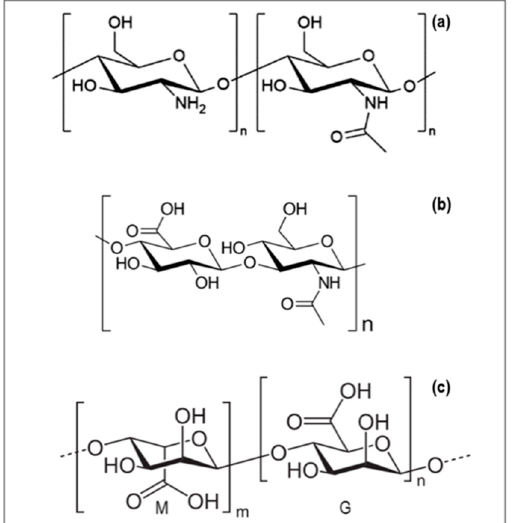
Figure 3. Molecular structures of: ( a ) Chitosan (CS); ( b ) hyaluronic acid (HA); and ( c ) alginic acid (M—mannuronic acid unit, G—guluronic acid unit).